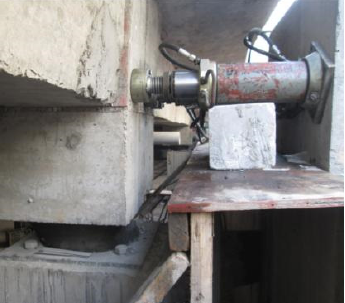
Figure 14. Distorted isolation bearing.